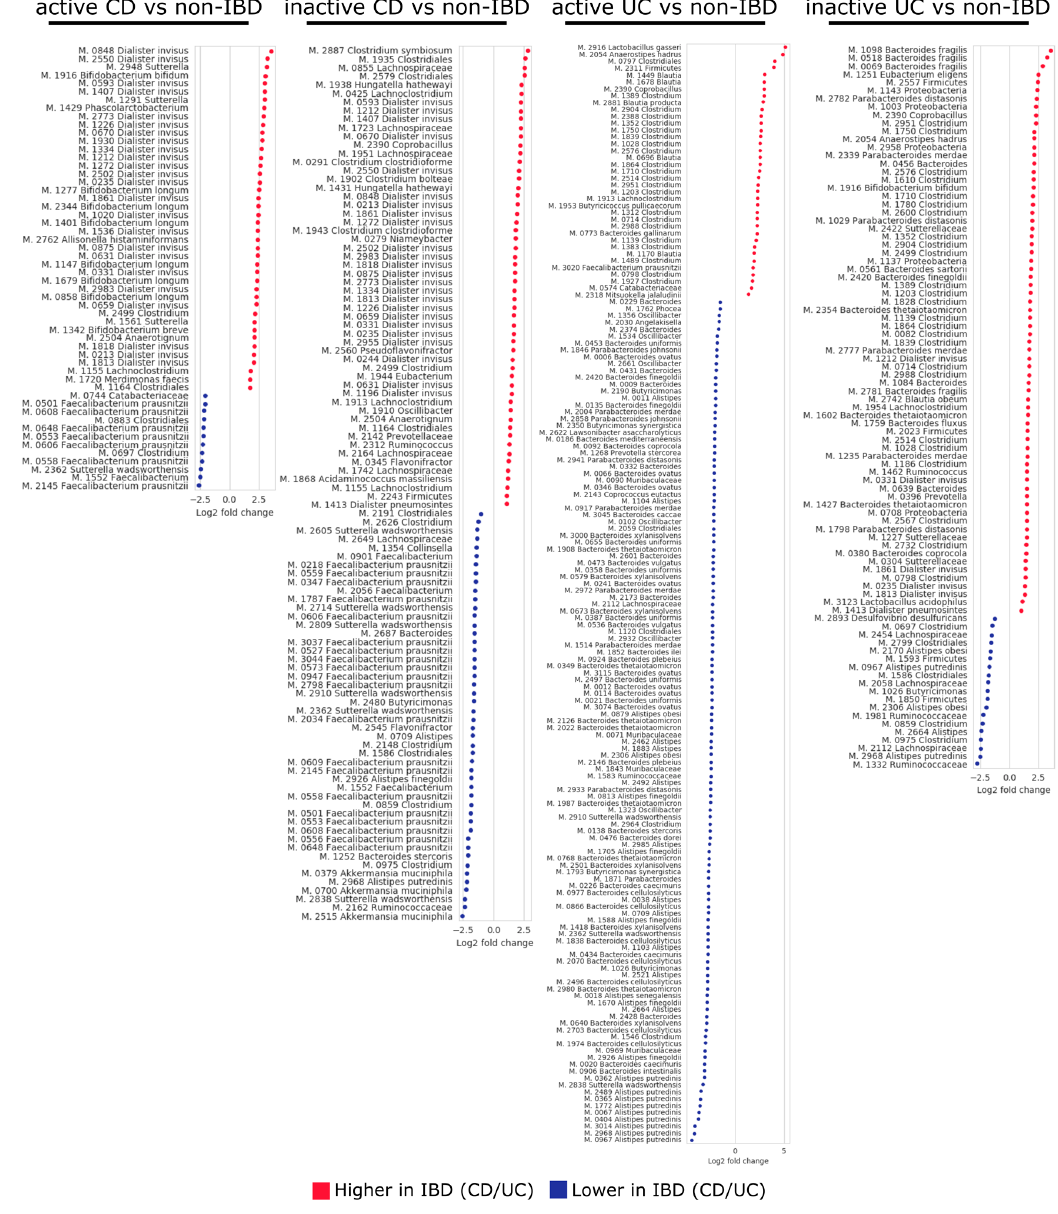
Figure 6. Log 2 fold-change values for bacteria displaying statistically significant differences in abundance between IBD and non-IBD patients (FDR < 0.1). Positive fold-change indicates a higher abundance in IBD patients, whereas a negative fold-change indicates higher abundance in non-IBD patients. MAG cluster is abbreviated to “M.” The following samples were used: 87 active CD samples from 24 patients, 448 inactive CD samples from 48 patients, 29 active UC samples from 9 patients, 298 inactive UC samples from 29 patients, and 362 non-IBD samples from 26 patients.